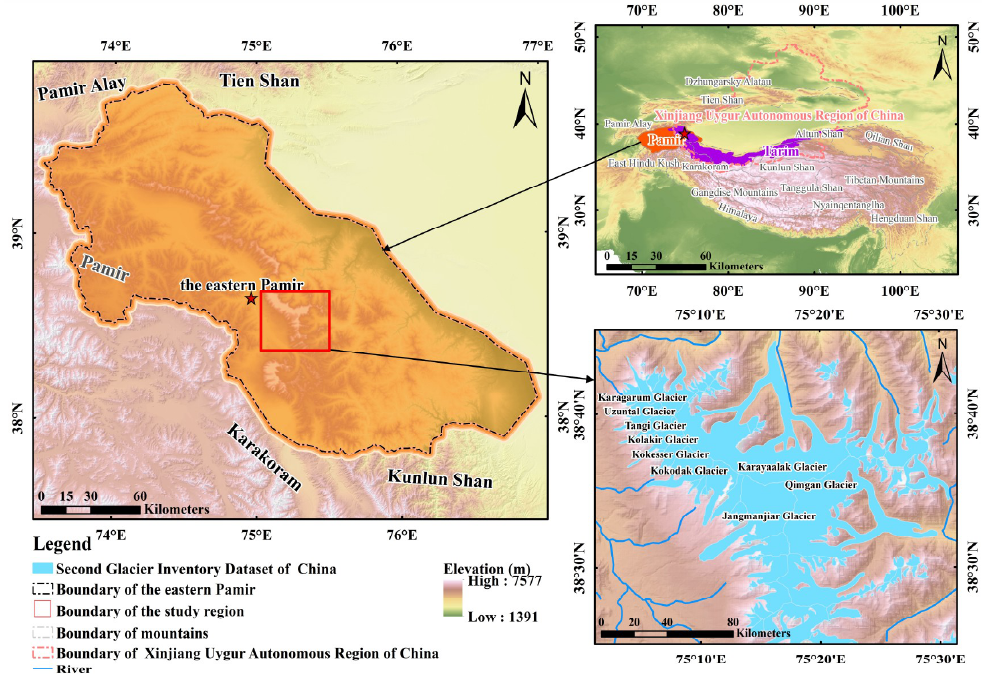
Figure 1. Location and elevation of the study area in the eastern Pamir.